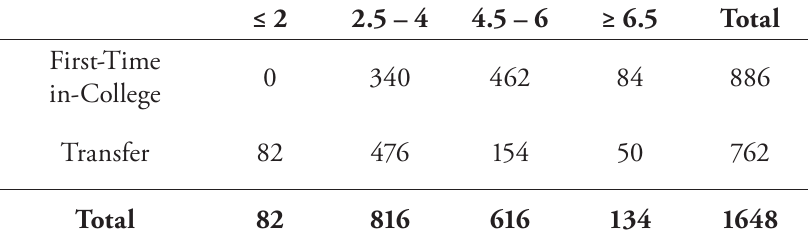
Table 3. Distribution of Earned Degrees by Admission Type and Time to Degree (Years at FSU) ≤